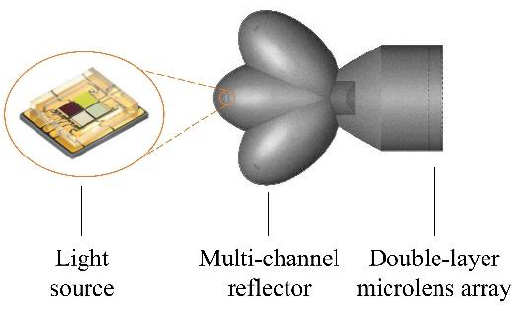
Figure 6. Optical system model. The wavelength of red light of the light source is 633 nm, green light is 521 nm, and blue light is 445 nm. The intensity distribution of the light source is Lambert type, and its size is 4 mm × 5 mm. The divergence angle of each LED in the light source is 120 degrees. The mixing effect on the target surface at a distance of one meter is shown in Figure 7.